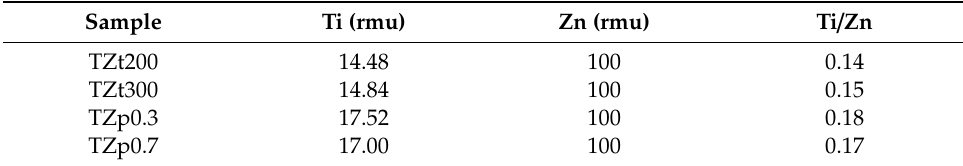
Table 1. Surface composition of the TZO thin films obtained by TXRF working down to the critical angle of the TZO material. Elemental masses are expressed as relative mass units